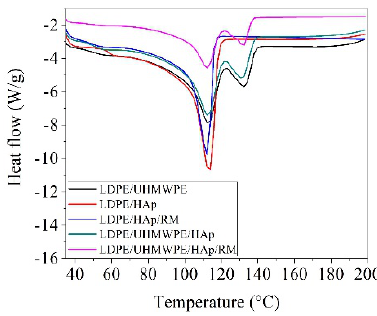
Figure 6. Differential scanning calorimetry (DSC) curves for LDPE composites. Figure 6. Di ff erential scanning calorimetry (DSC) curves for LDPE